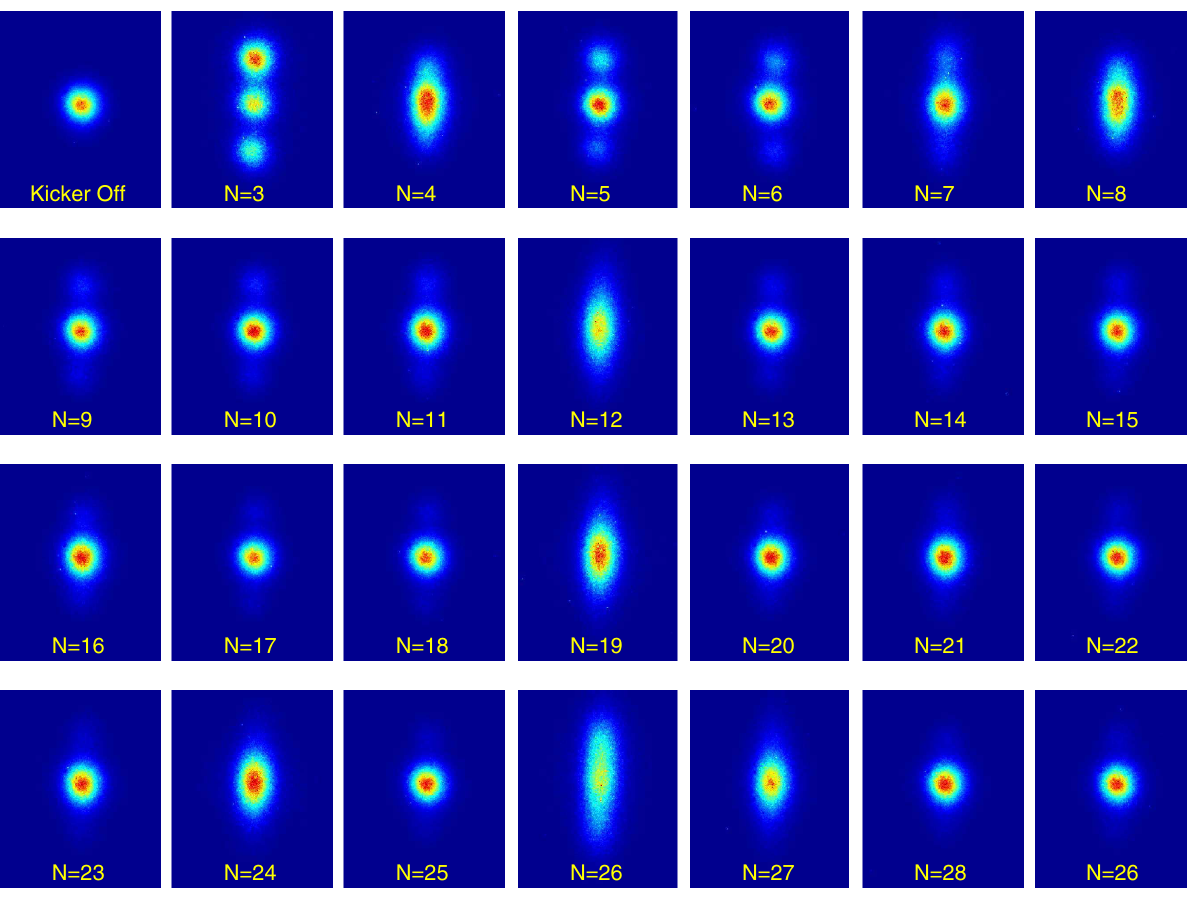
FIG. 11. Beam images measured at different KAC period N from 3 to 28. The image at the upper left corner is measured when the camshaft kicker is turned off. The lower right image is a stabilized KAC beam at N ¼ 26 by adjusting the horizontal tune of the machine away from the